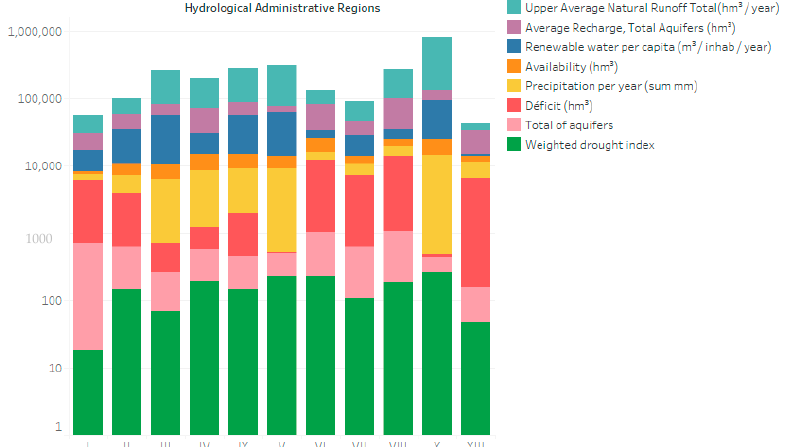
Figure 5. Comparative graph of the magnitude of the variables related to agricultural drought using the total sum of the observations transformed into a natural logarithm, with the differences between them presented using the proposed histogram, showing their differences by region and variable.